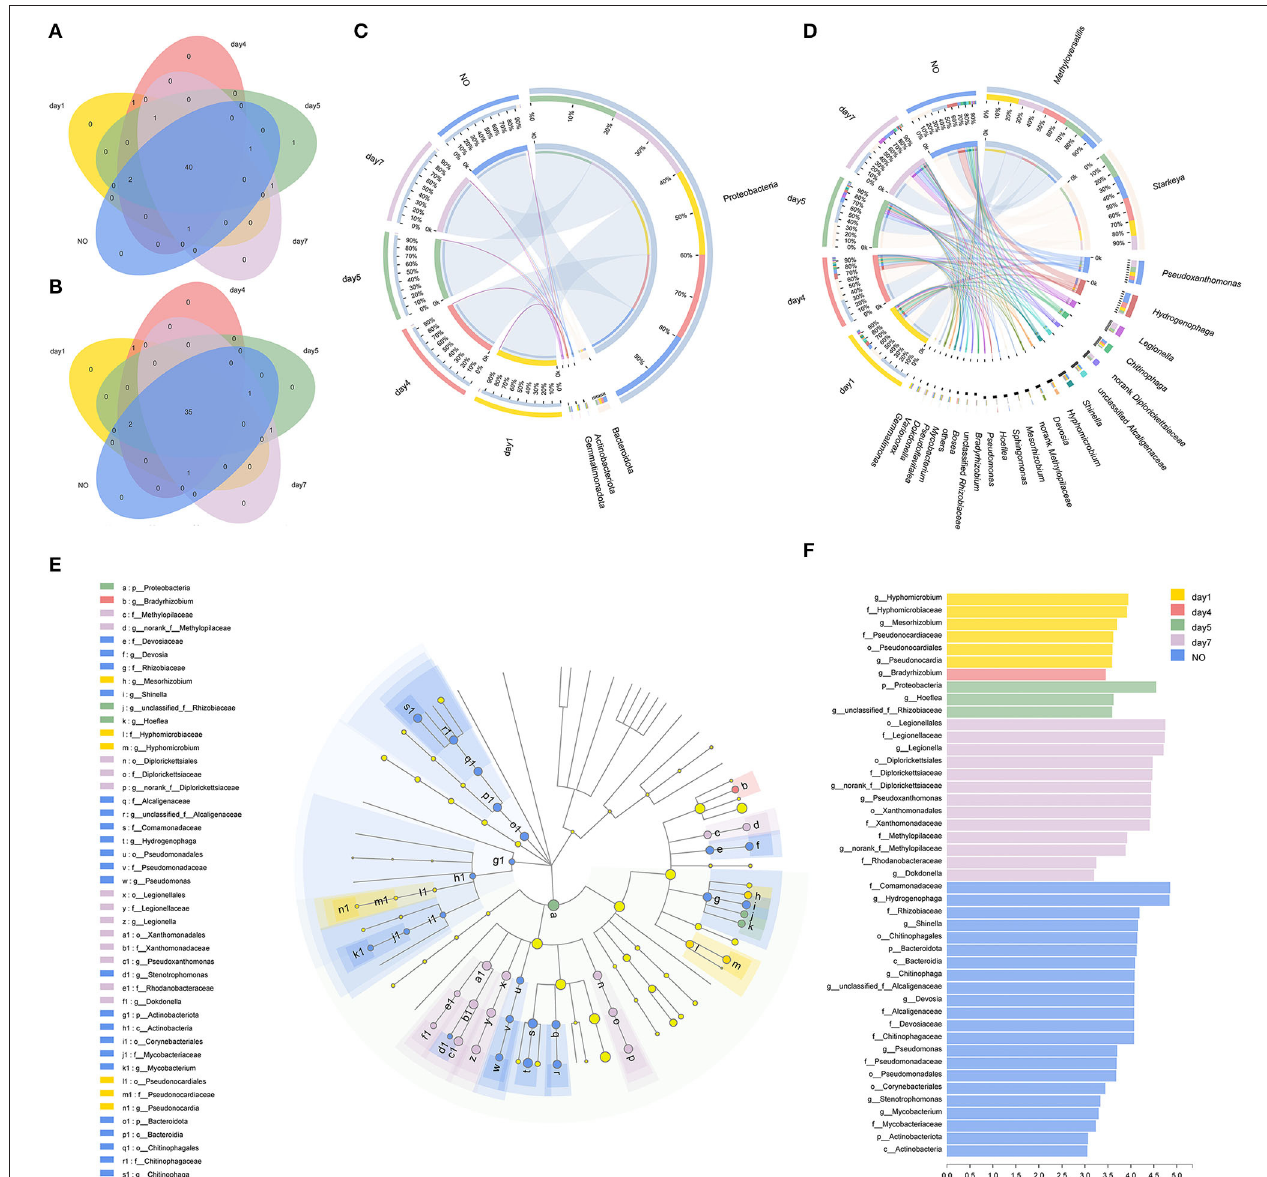
FIGURE 3 | The evolution of bacterial community compositions among different time points and the incapacitated consortium. (A,B) Venn diagrams showed the shared and unique numbers of bacterial operational taxonomic units (OTUs) (at 97% identity) and genera among the five groups; (C,D) relationships between samples and phyla/genera are shown in Circos figures. Phylogenetic groups accounting for ≤ 1% of all classified sequences are summarized in the artificial group “others”; (E,F) phylogenetic cladogram of biomarker bacteria and indicator bacteria with linear discriminant analysis (LDA) scores of ≥ 3 in bacterial communities.